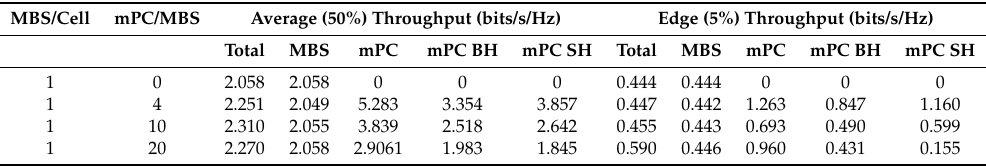
Table 4. Average and edge throughput comparison by adding mPC in conventional